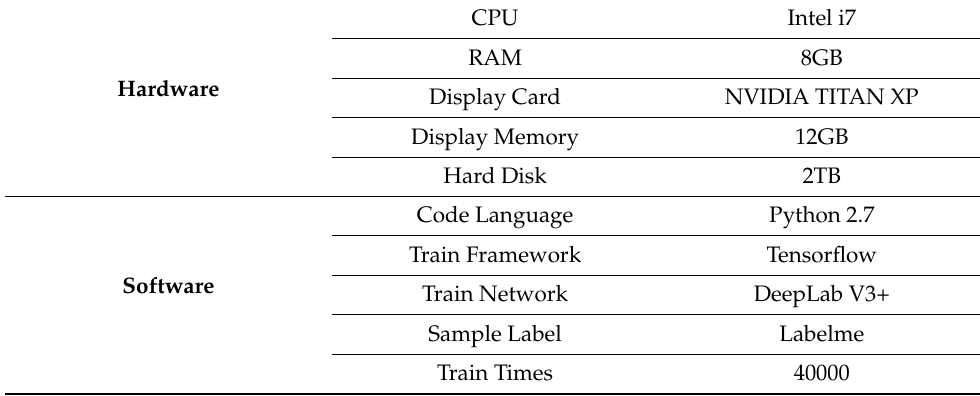
Table 1. Technical specification of hardware and software used in this study for training of the DeepLab V3+ network.